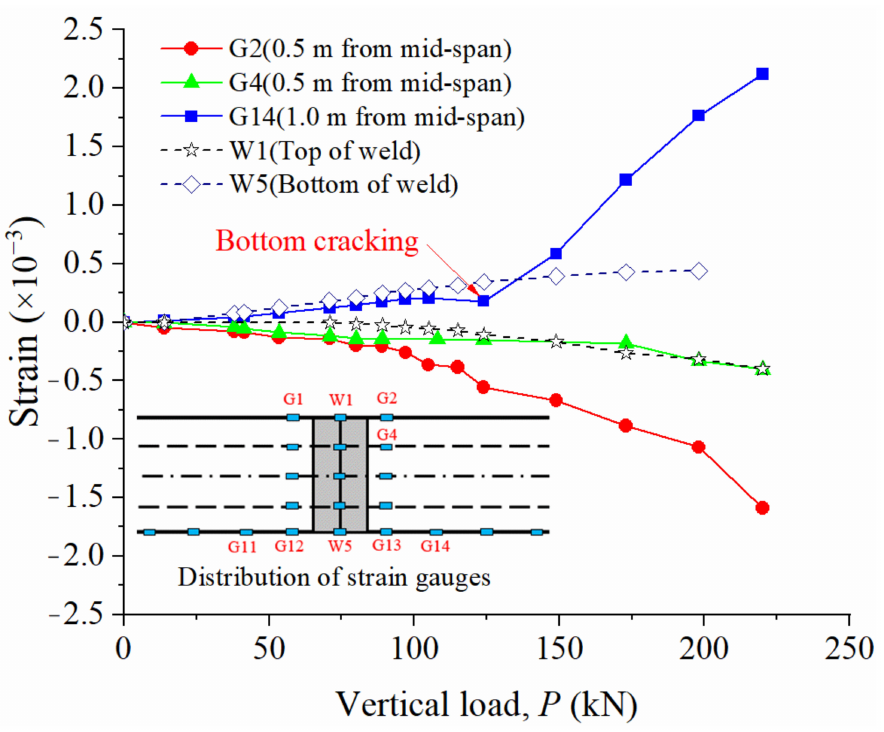
Figure 7. Strain variation characteristics of joint JT2.